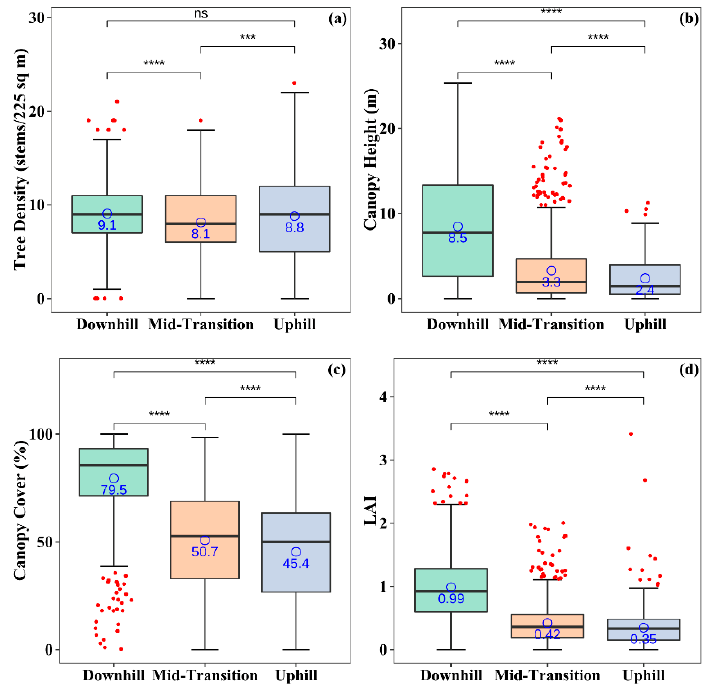
Figure 7. Significance boxplot of forest indexes on different landform units. ( a ) Tree Density; ( b ) Canopy Height; ( c ) Canopy Cover; ( d ) Leave Area Index. Blue circles and numbers are the mean values of each group. Red dots are the outliers. The p -value levels are symbolized as (1) ns: p > 0.05, (2) ***: p < 0.001, (3) ****: p < 0.0001.